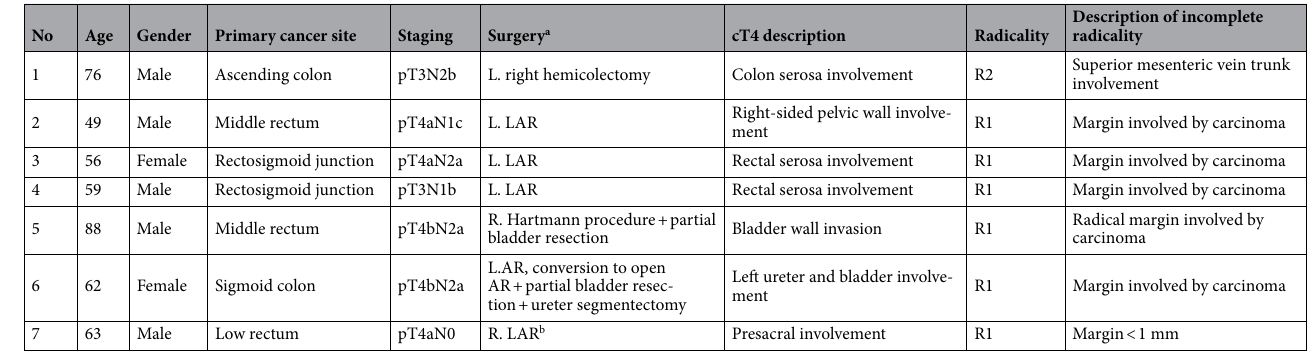
Table 4. Clinically M0 patients with R1 or R2 resection. a “L.” is the abbreviation of “laparoscopic”. LAR: low anterior resection. AR: anterior resection. “R.” is the abbreviation of “robotic”. b The patient received preoperative neoadjuvant